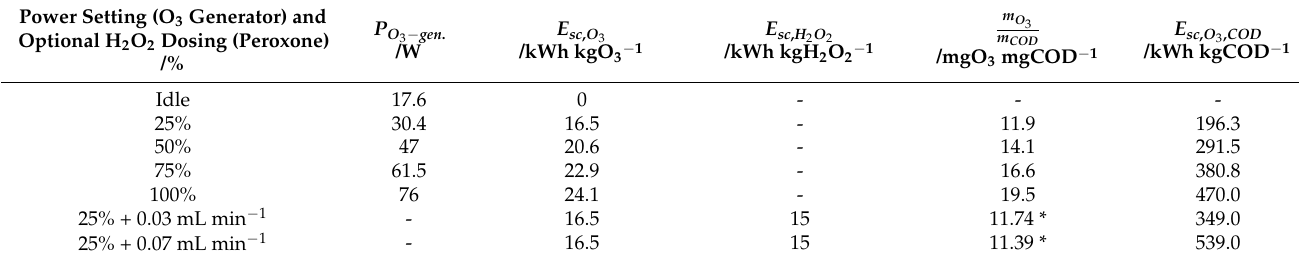
Table 2. Influence of ozone and peroxone inputs on wastewater treatment after 24 h experiments at room temperature. P O3-gen denotes the power consumption for the selected power settings of the O 3 generator. E sc , O denote the specific energy per mass O 3 , per mass H 2 O 2 , and per mass COD, respectively. The mass O 3 demand in dependence to the mass COD is given by 15 kWh kgH 2 O 2 − 1 according to